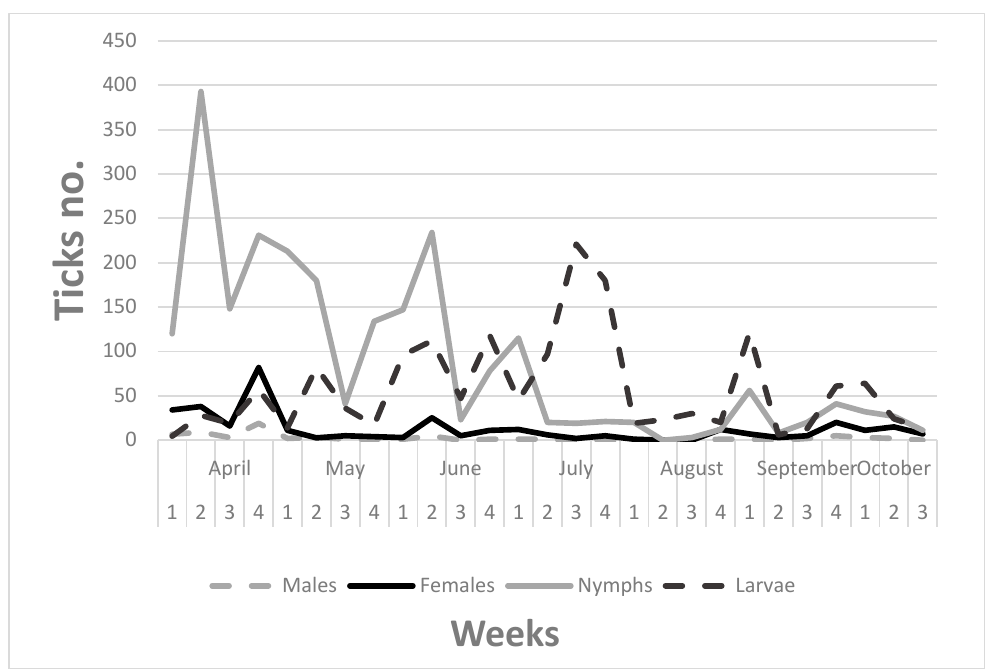
Figure 3. Seasonality of Ixodes ricinus ticks dropped o ff the hedgehogs.